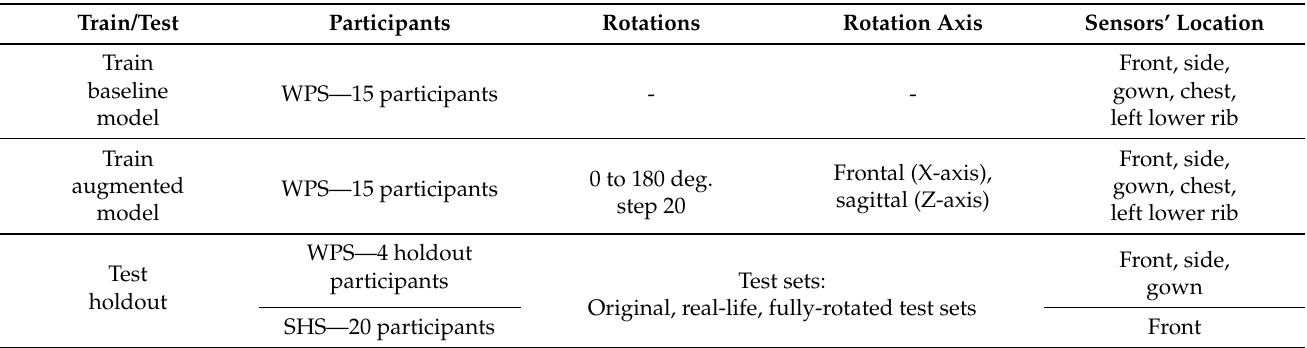
Figure 3. Augmented test set visualization. ( a ) The original sensor orientation compared to the standing human body. ( b ) The applied rotations of the real-life test set along the frontal and sagittal axis. ( c ) The three non-simultaneous rotations applied along the frontal, longitudinal, and sagittal axis (r1, r2, r3) with the fully-rotated test set. Table 3. Train and test settings for the baseline and the augmented model computation. The baseline model training did not undergo data augmentation. The two models were tested in the same way by means of three test